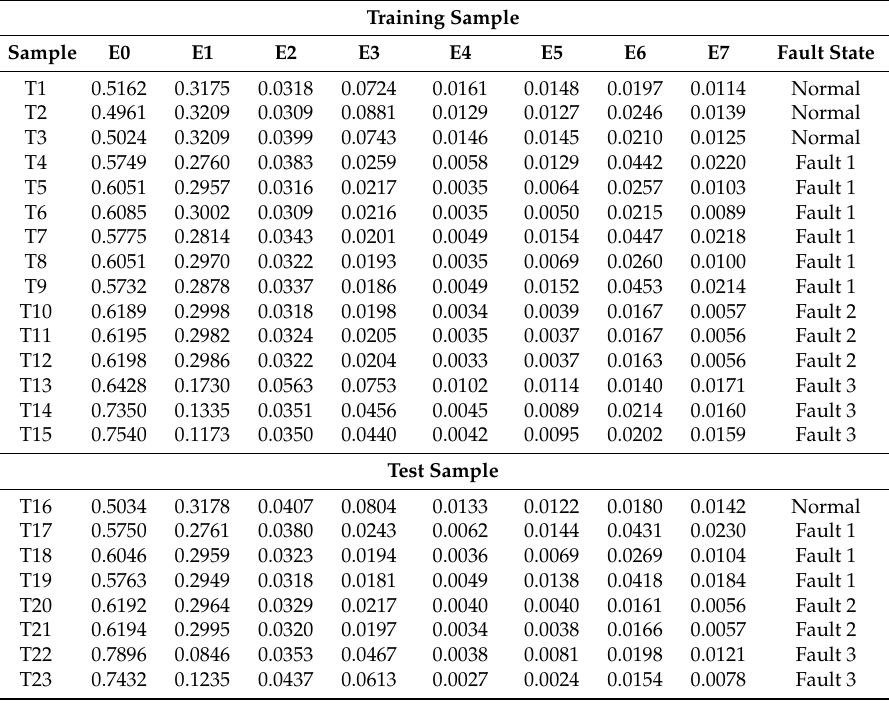
Table 2. The energy eigenvector of the stator current sample signals.